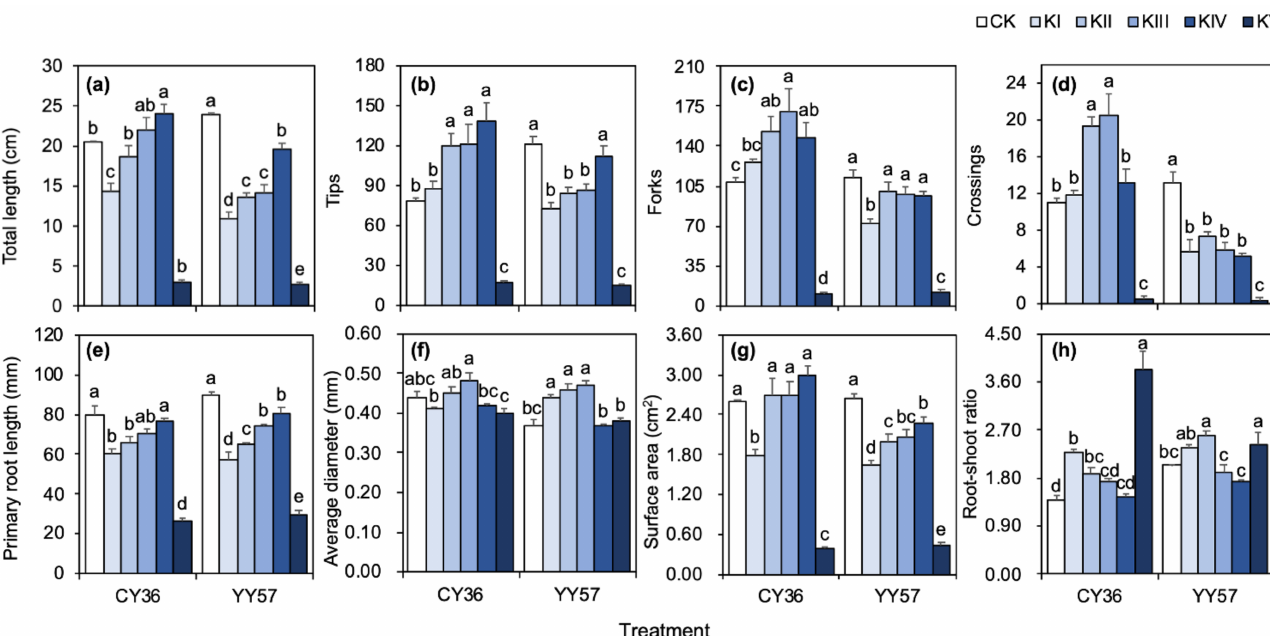
Figure 1. Effects of K supply level on the root system architecture: ( a ) total length, ( b ) the number of tips, ( c ) the number of forks, ( d ) the number of crossing, ( e ) primary root length, ( f ) average diameter, ( g ) surface area, ( h ) root-shoot ratio of two rapeseed cultivars. KI, KII, KIII, KIV, and KV indicate K supply level (K 2 SO 4 ) 0, 0.1, 1, 10, and 100 mM under drought stress with 15% PEG, respectively, and CK indicate the control (without 15% PEG) 0.1 mM K 2 SO 4 . Means and standard errors ( n = 4). Different small letters mean significant differences in Duncan multiple range tests among different treatments at 5% level ( p <